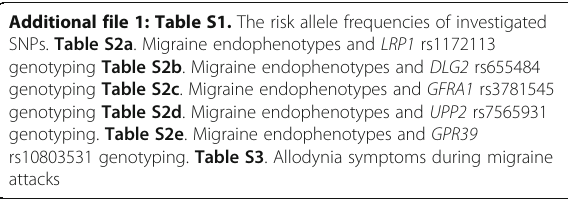
Additional file 1: Table S1. The risk allele frequencies of investigated SNPs. Table S2a . Migraine endophenotypes and LRP1 rs1172113 genotyping Table S2b . Migraine endophenotypes and DLG2 rs655484 genotyping Table S2c . Migraine endophenotypes and GFRA1 rs3781545 genotyping Table S2d . Migraine endophenotypes and UPP2 rs7565931 genotyping. Table S2e . Migraine endophenotypes and